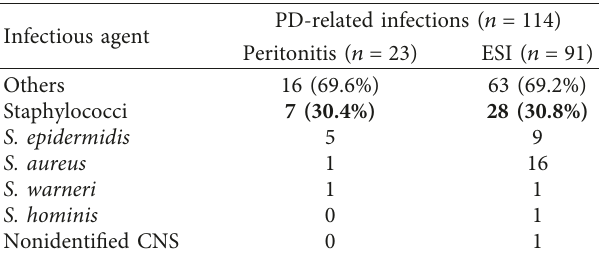
Table 6: Total number of infectious episodes and Staphylococcus species identified in peritonitis and exit-site infections (ESI) of PD patients.